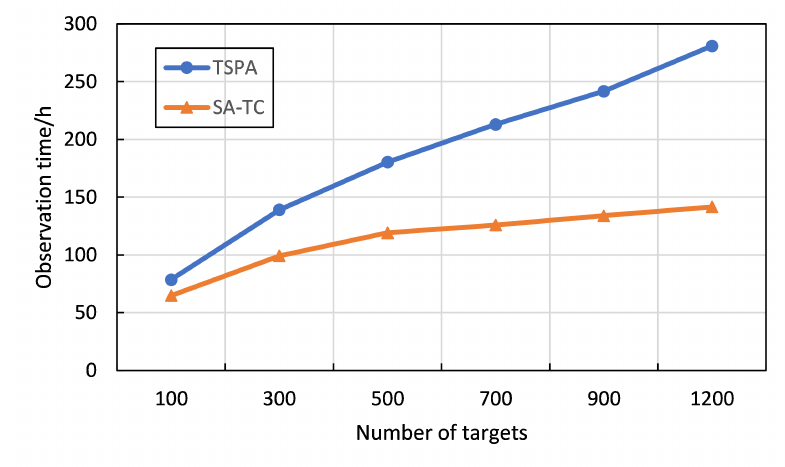
Figure 5. Comparison results of TSPA and SA-TC with different numbers of targets.